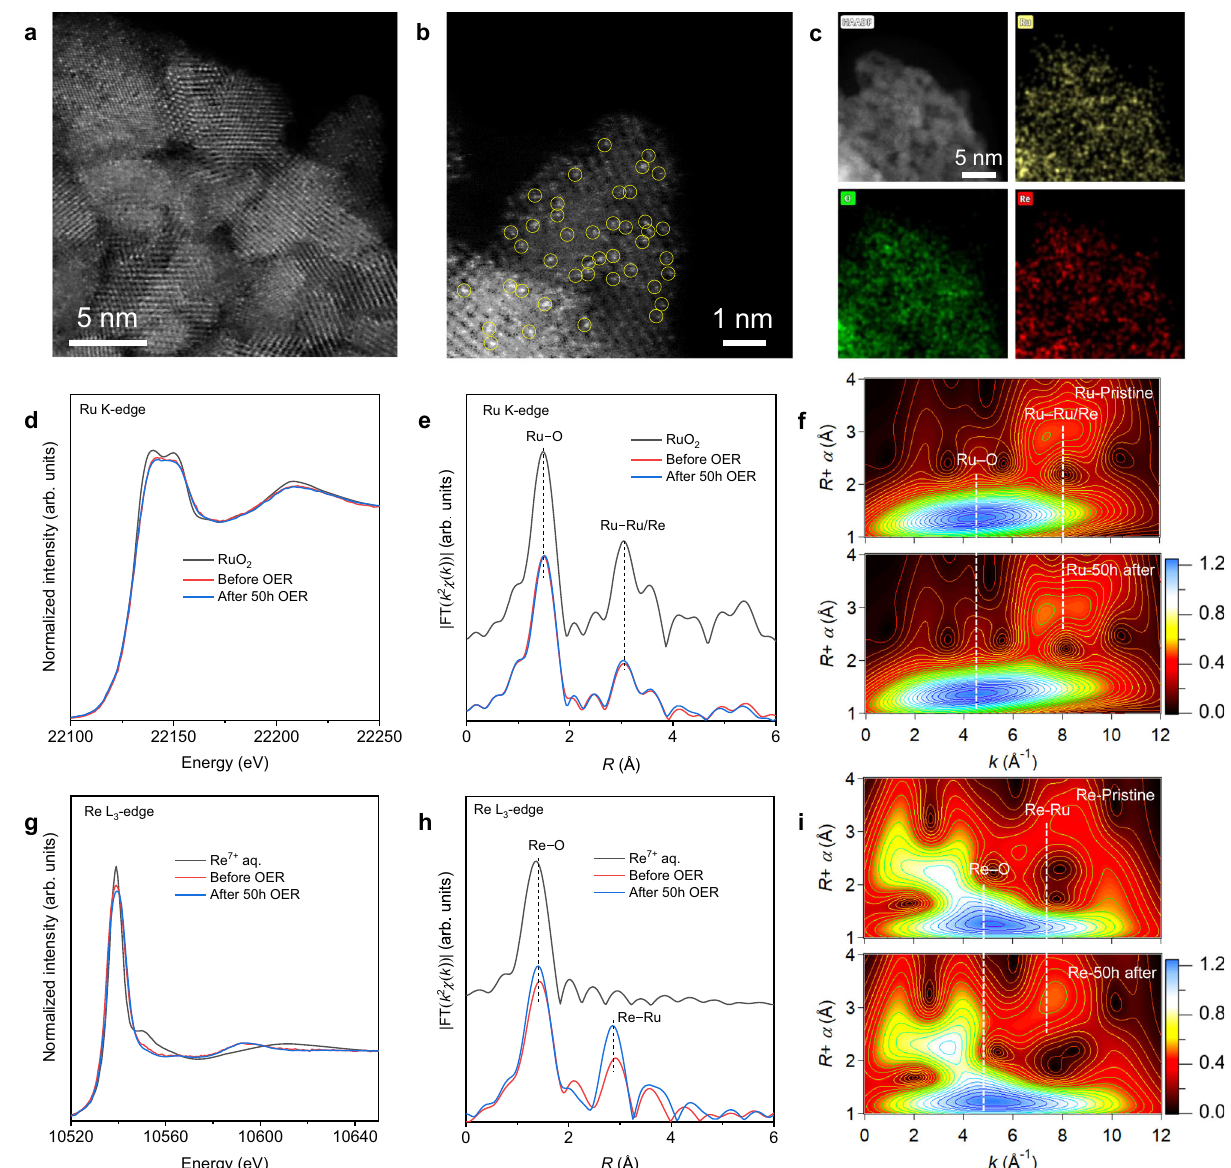
Fig. 2 | Structural characterization of Re 0.06 Ru 0.94 O 2 after 50h OER in acid. a , b Aberration-correctedHAADF-STEMimageofRe 0.06 Ru 0.94 O 2 after50hOER.Re sites arelabeled withyellow-colorcircles. c EDSmapping images of Re 0.06 Ru 0.94 O 2 catalyst after 50h OER. d , e Ru K-edge XANES spectra and FT k 2 -weighted EXAFS signals for RuO 2 , Re 0.06 Ru 0.94 O 2 before and after 50h OER. f Comparison of Ru